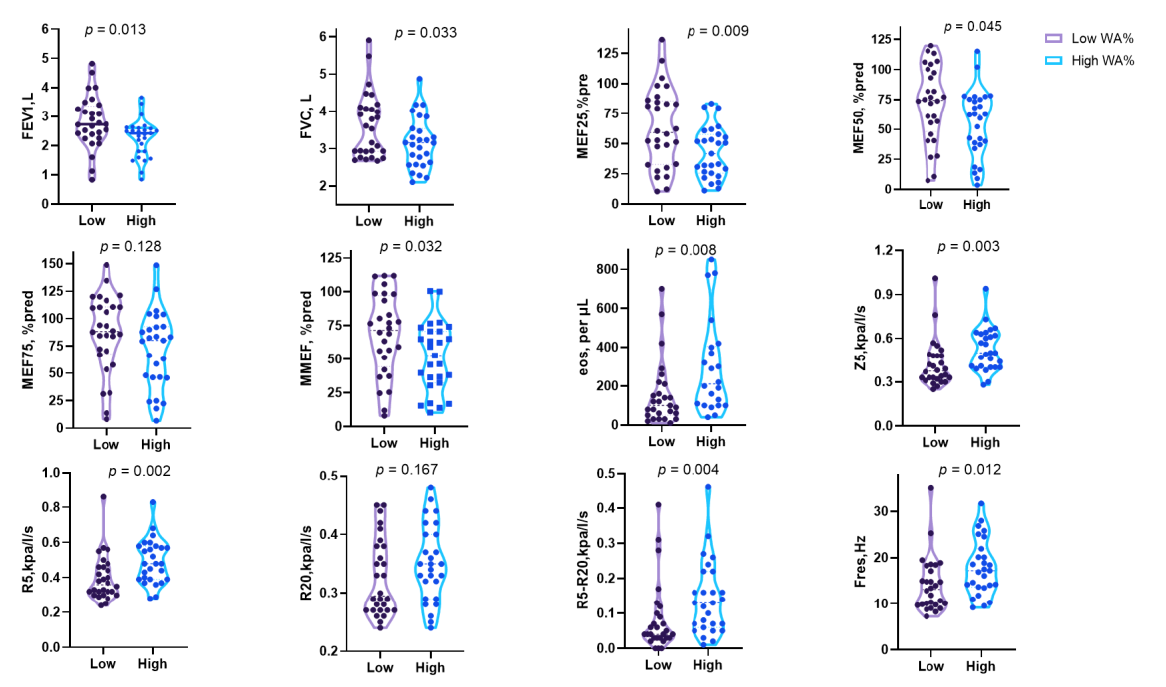
Figure 5. Spirometry and lung airway resistance parameters according to the airway wall thickness stratified by WA%. Data expressed as median and interquartile range.